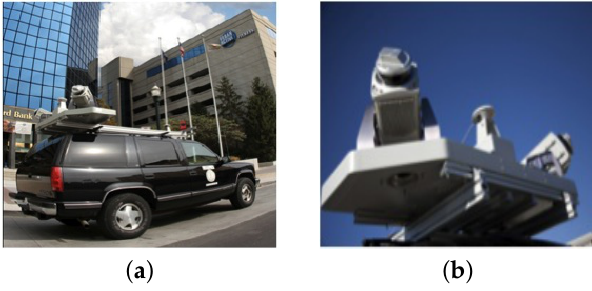
Figure 1. ( a ) The Vis Center’s LiDAR Truck. ( b ) Two Optech LiDAR sensor heads, a GPS, an inertial measurement unit and a spherical digital camera mounted on a rigid frame.